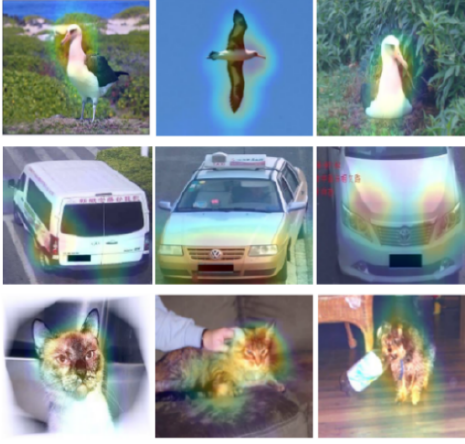
Figure 3. Saliency maps of different images.